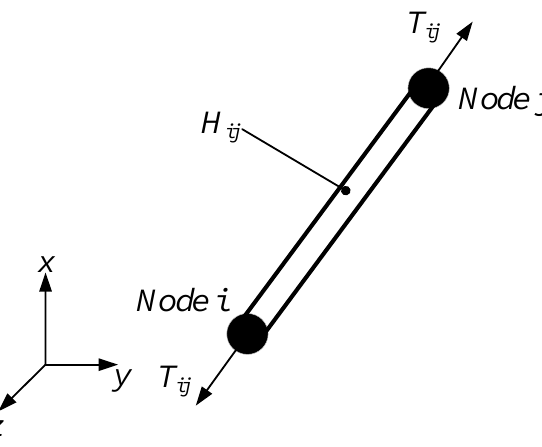
Figure 5. Stress of the truss element.